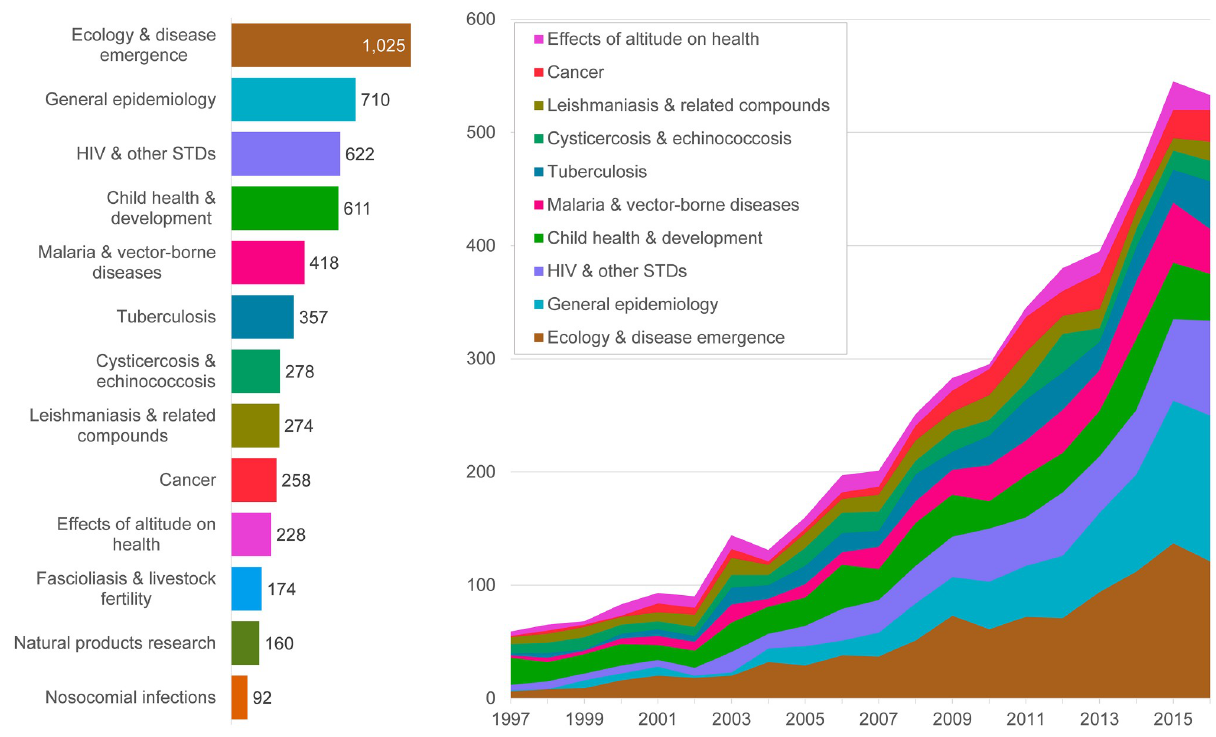
Fig 1. Number of Peruvian publications by year and topic, 1997–2016. Data from WOS, N = 6032.